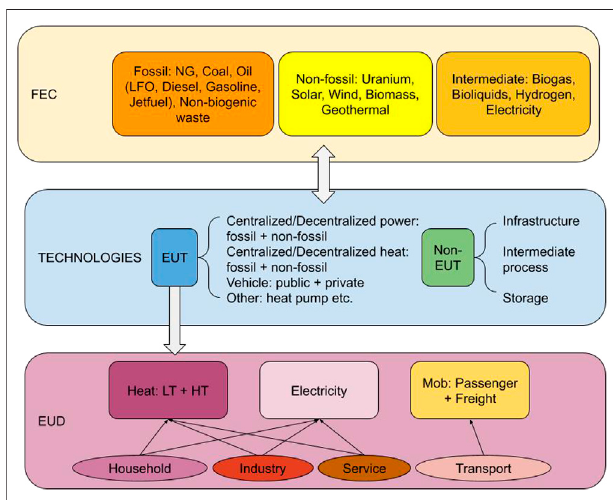
FIGURE 1 | Typology of